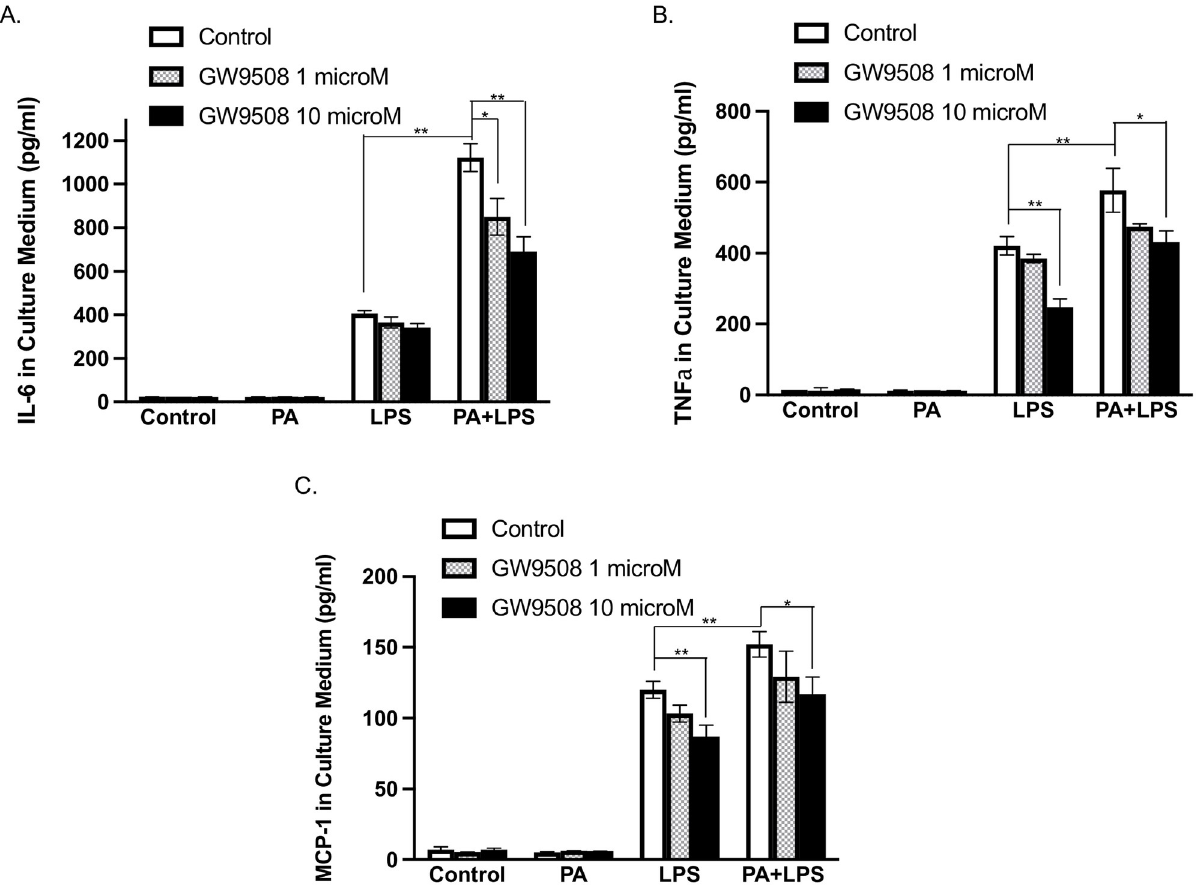
Fig 9. The effect of GPR40 agonist on proinflammatory cytokine expression stimulated by PA or PA plus LPS in macrophages. RAW264.7 macrophages were treated with 100 μ M of PA, 1 ng/ml of LPS or both in the absence or presence of 1 or 10 μ M of GW9508 for 24 h. After the treatment, the culture medium was collected for ELISA for quantifing IL-6 (A), TNF α (B) and MCP-1 (C). The presented data (means ± SD) were representative of three experiments with similar results. Student’s t test was used for the statistical analysis. � p < 0.05; �� p < 0.01. PA, palmitic acid; LPS,